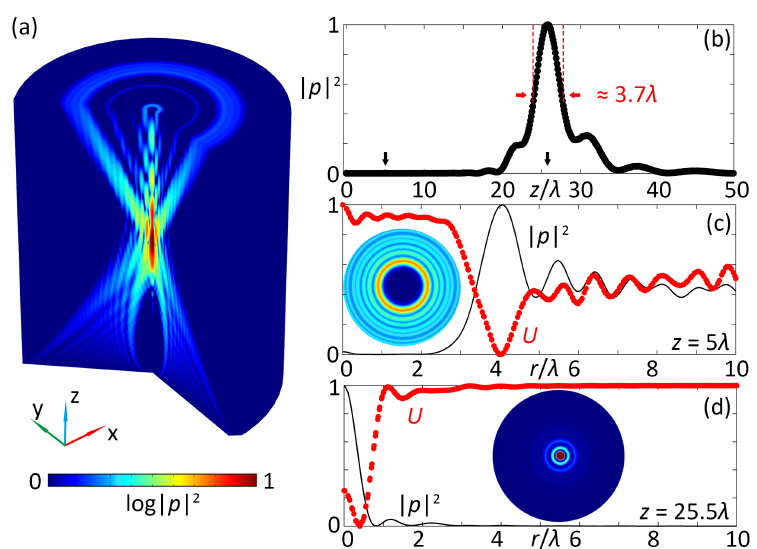
Figure 5. Particle manipulation based on the bottle sound beam. ( a ) Simulated three-dimensional bottle sound beam. ( b ) Normalized sound field | p | 2 profile along the central beam axis. Normalized sound fields | p | 2 and the force potential U in the transverse direction at ( c ) z ≈ 5 λ and ( d ) z ≈ 25.5 λ . Insets: corresponding two-dimensional sound fields of x − y cross